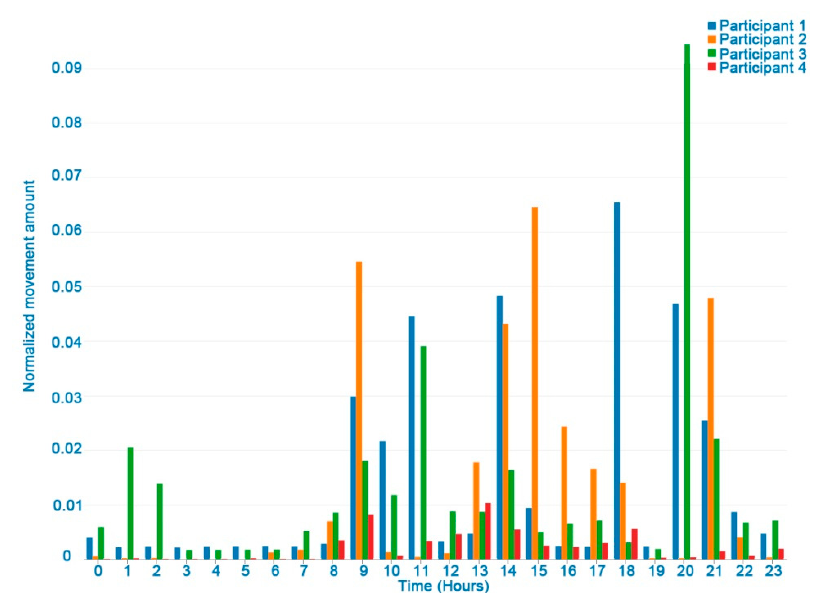
Figure 4. Normalized number of movements of participants in a one day HDRS monitoring period.